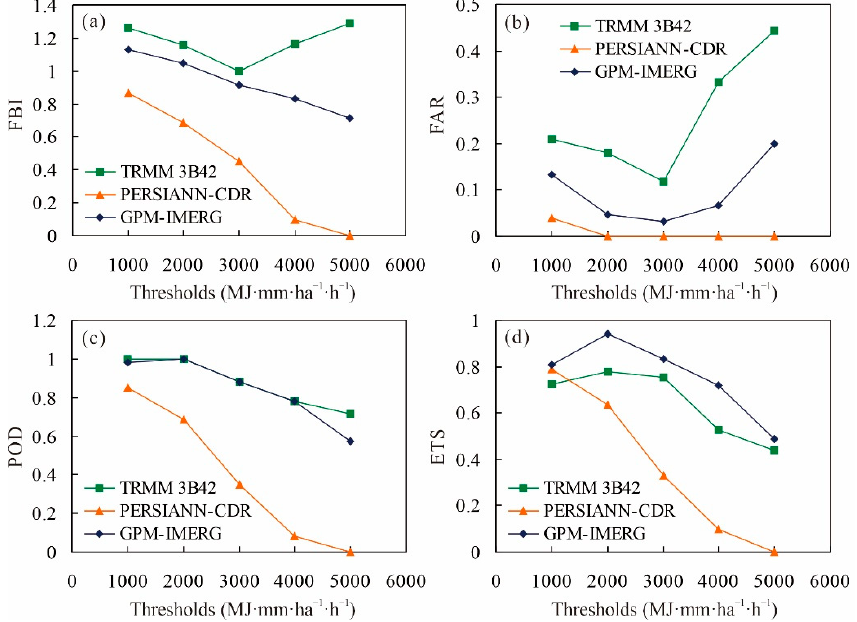
Figure 8. Changes in FBI ( a ), FAR ( b ), POD ( c ), and ETS ( d ) scores at different thresholds on the seasonal